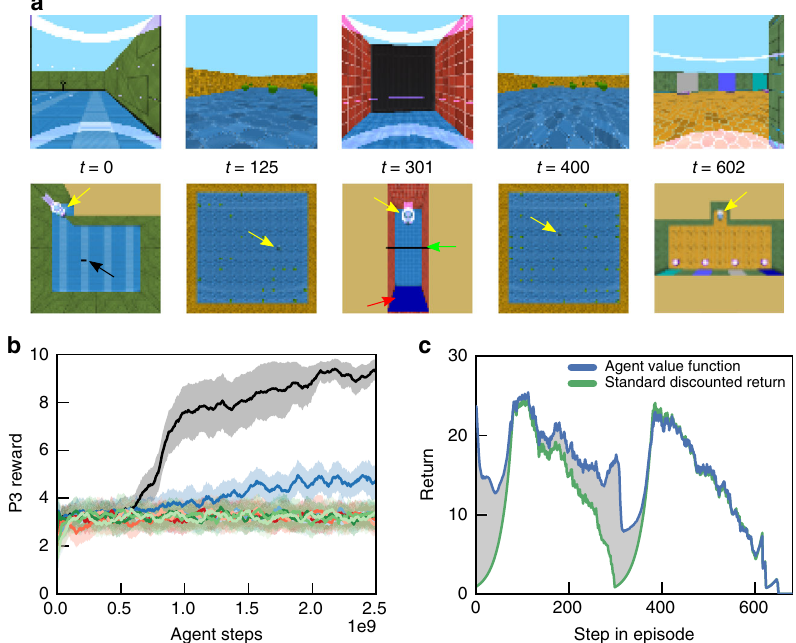
Fig. 5 Transport across multiple phases. a Key-to-Door-to-Match (KtDtM) task. The agent (yellow arrow) must pick up a key (black arrow) in P1 to open a door (green arrow) and encode a colored square (red arrow) in P3 to select the matching colored square in P5 (Supplementary Movie 3). P2 and P4 are distractor apple collecting tasks. b TVT (black) solved this task, whereas RMA (blue) solved the P5 component of the task when it by chance retrieved the P1 key and opened the door in P3. c The value function prediction (blue) in TVT developed two humps where it was above the discounted return trace (green), one in P1, one in P3, encoding the value of achieving the “ sub-goals ” in P1 and